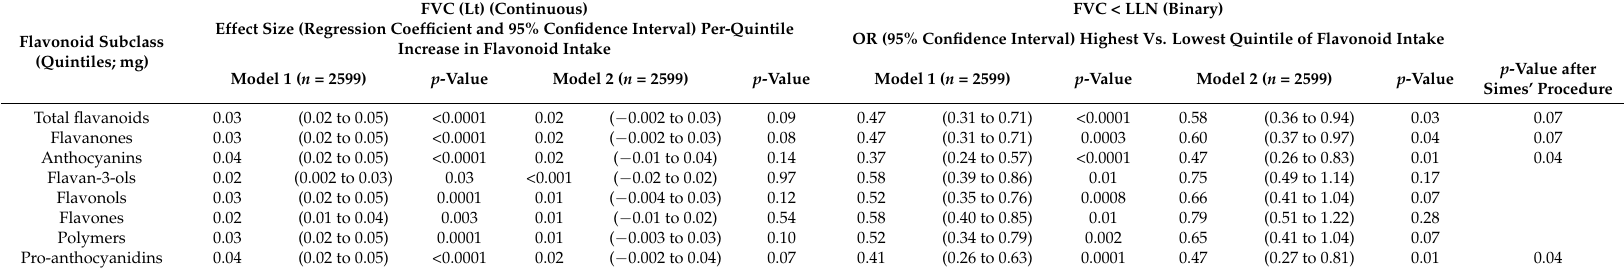
Table 4. Association of post-bronchodilator spirometric values of FVC and FVC < LLN with dietary intake of flavonoids.